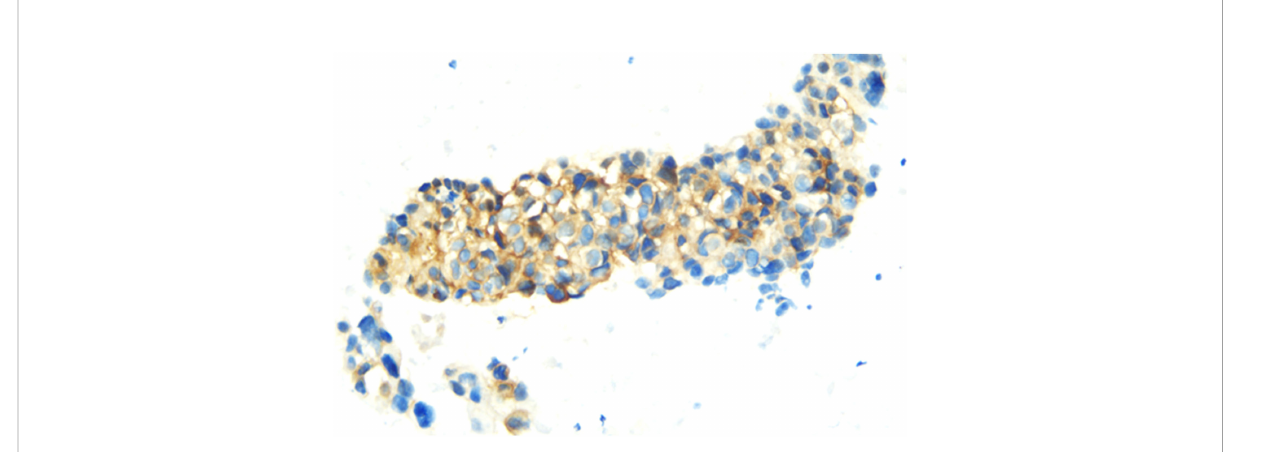
FIGURE 2 Immunohistochemical staining of MET showing positive in LADC biopsy specimens at 40x.